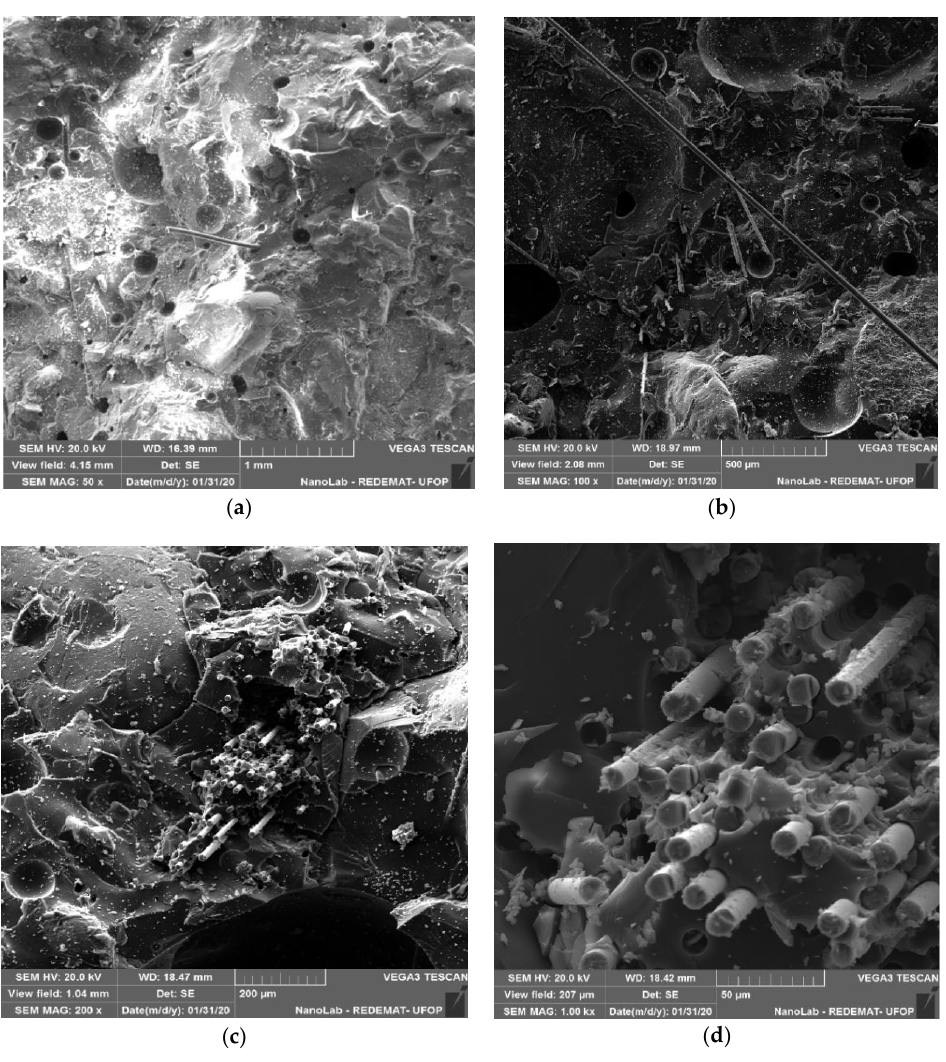
Figure 21. Flexural surface of the matrix of epoxy resin and polypropylene fibre ( a ) 50×; ( b ) 100×; ( c ) 200×; ( d ) 1000× magnification.